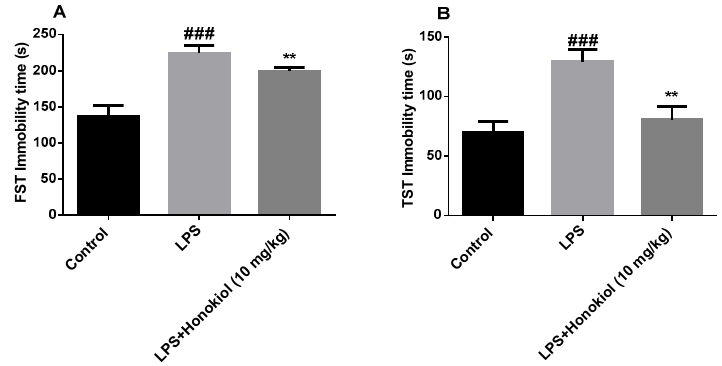
Figure 2. The effects of honokiol on ( A ) the forced swim test (FST) and ( B ) the tail suspension test (TST). Data are expressed as mean ± SEM ( n = 10/group). ### p < 0.001 LPS vs control; ** p < 0.01 LPS + Honokiol vs LPS.